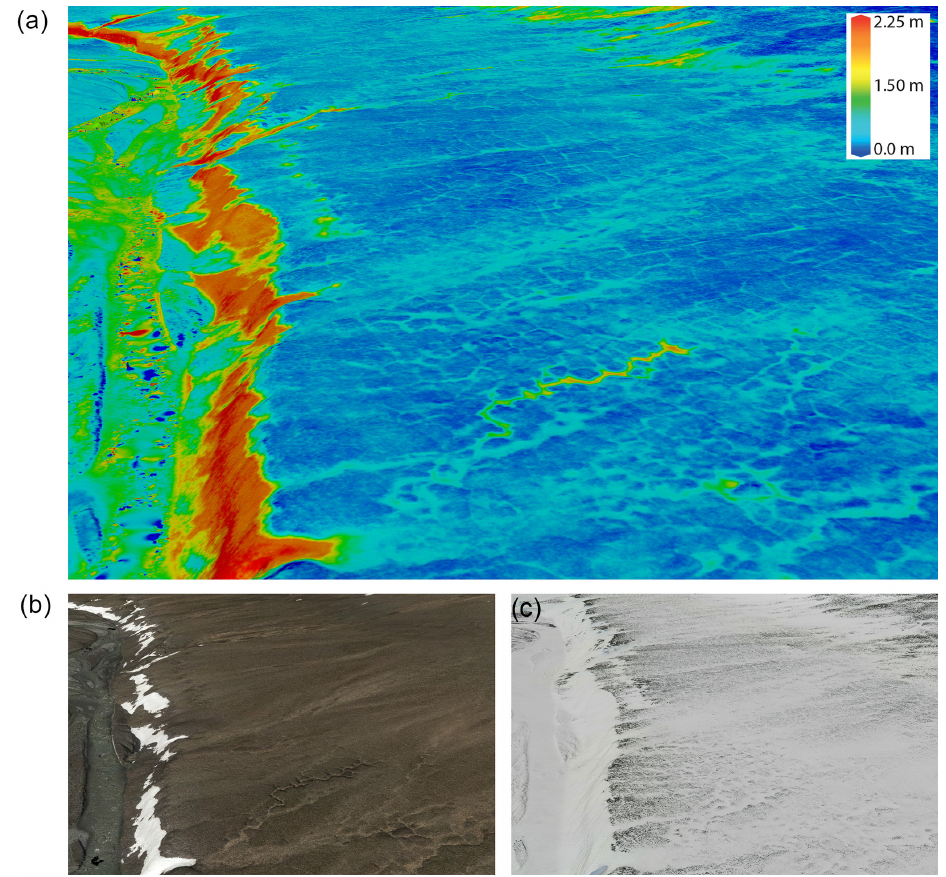
Figure 1. (a) An oblique view of snow depth in the Hulahula River valley in Arctic Alaska produced by the photogrammetric technique described in the text. In the foreground, ice wedges and small gullies a few meters in width are filled with snow ranging from centimeters to decimeters in depth (light blue, green and yellow). At left, drifts over 2m thick have formed in the lee of a bluff (red) and have not completely melted by June (b) . This map was created by subtracting a summer DEM (13 June 2014) from a winter DEM (20 April 2014), as shown in (b) and (c) , respectively. Comparison of our airborne measurements to 3382 direct measurements here show agreement to ± 16cm standard